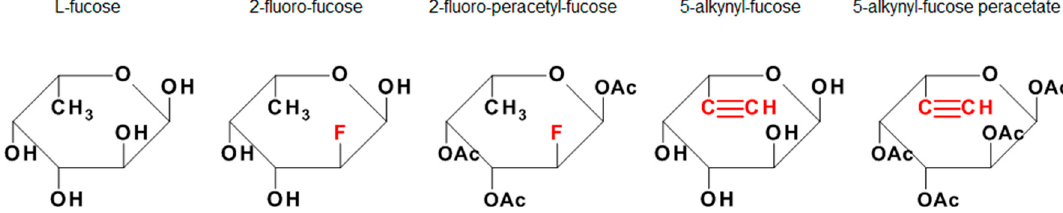
Figure 1. L-Fucose and its monosaccharide analogues used in this study. The key structural modifications are highlighted in modifications are highlighted in red.